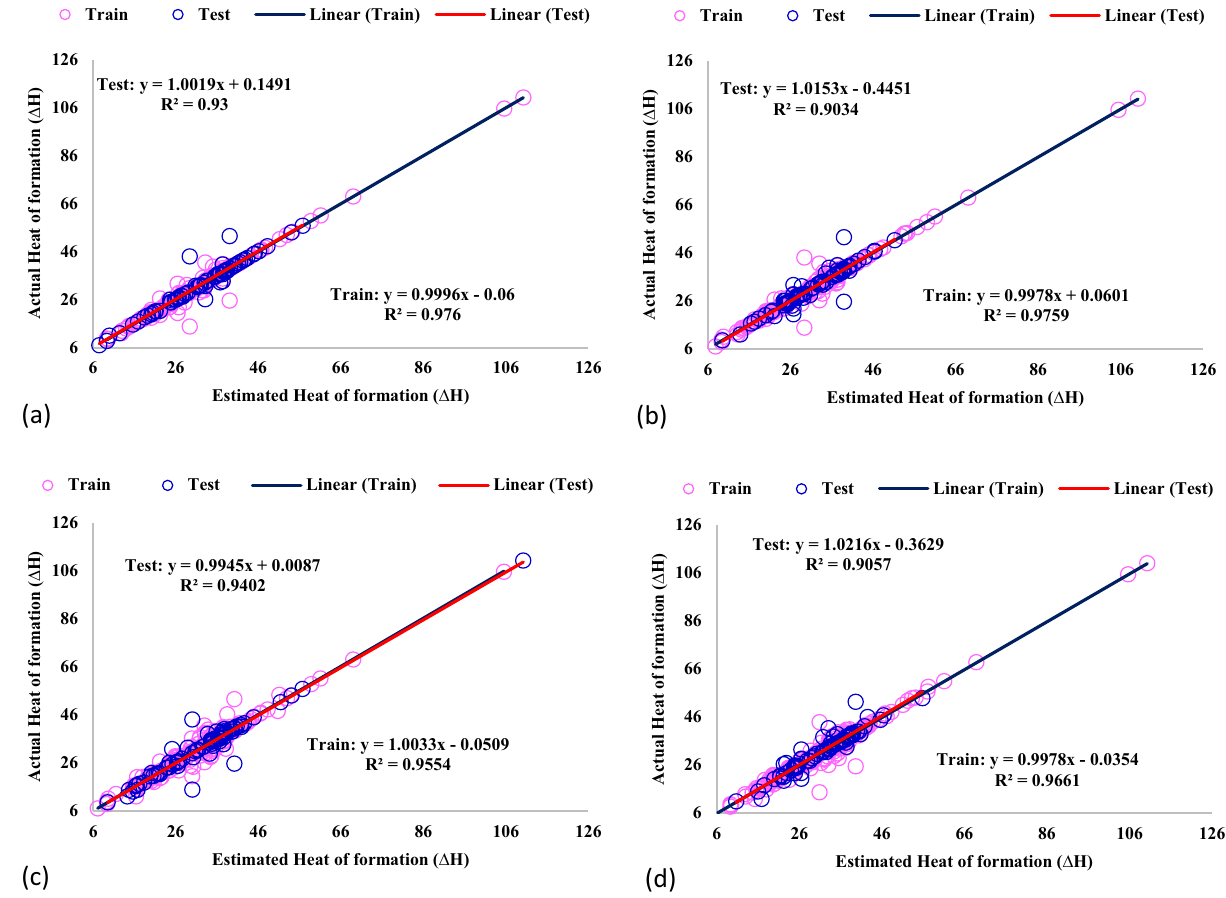
Figure 5. Cross plots for GPR model with kernel function of ( a ) Exponential), ( b ) Matern, ( c ) Squared exponential, ( d ) Rational